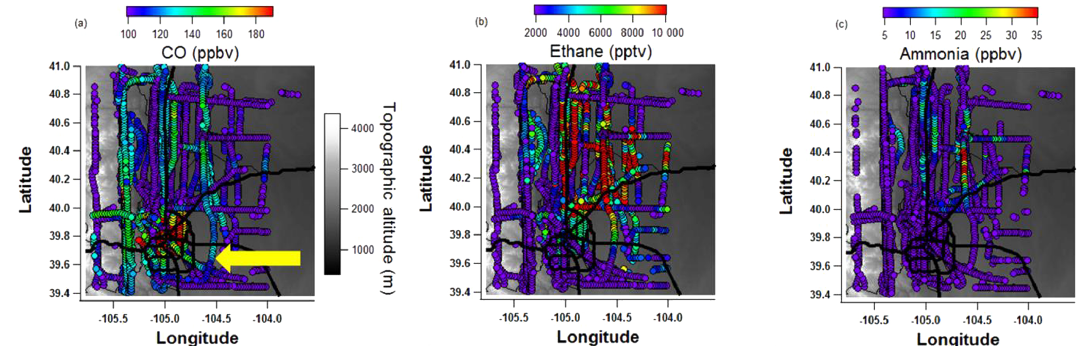
Figure 1. C-130 flight tracks in the Colorado Front Range, color coded with observed mixing ratios of (a) CO, (b) ethane, and (c) ammonia. The yellow arrow indicates the Denver metropolitan area. To the west of the Denver metropolitan area are the Rocky Mountain foothills depicted by the topographic color